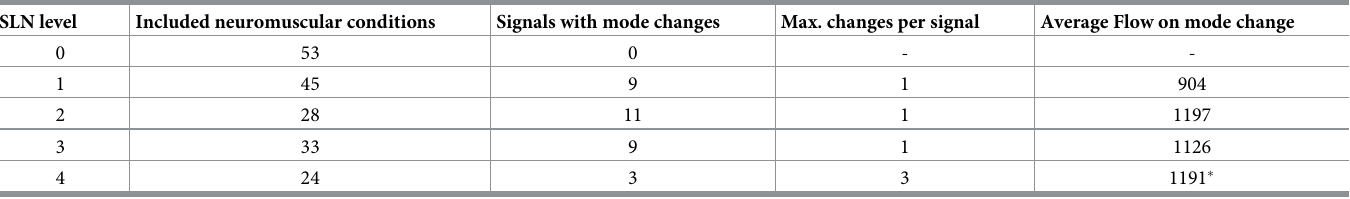
Table 3. Observed F0 mode changes relative to SLN